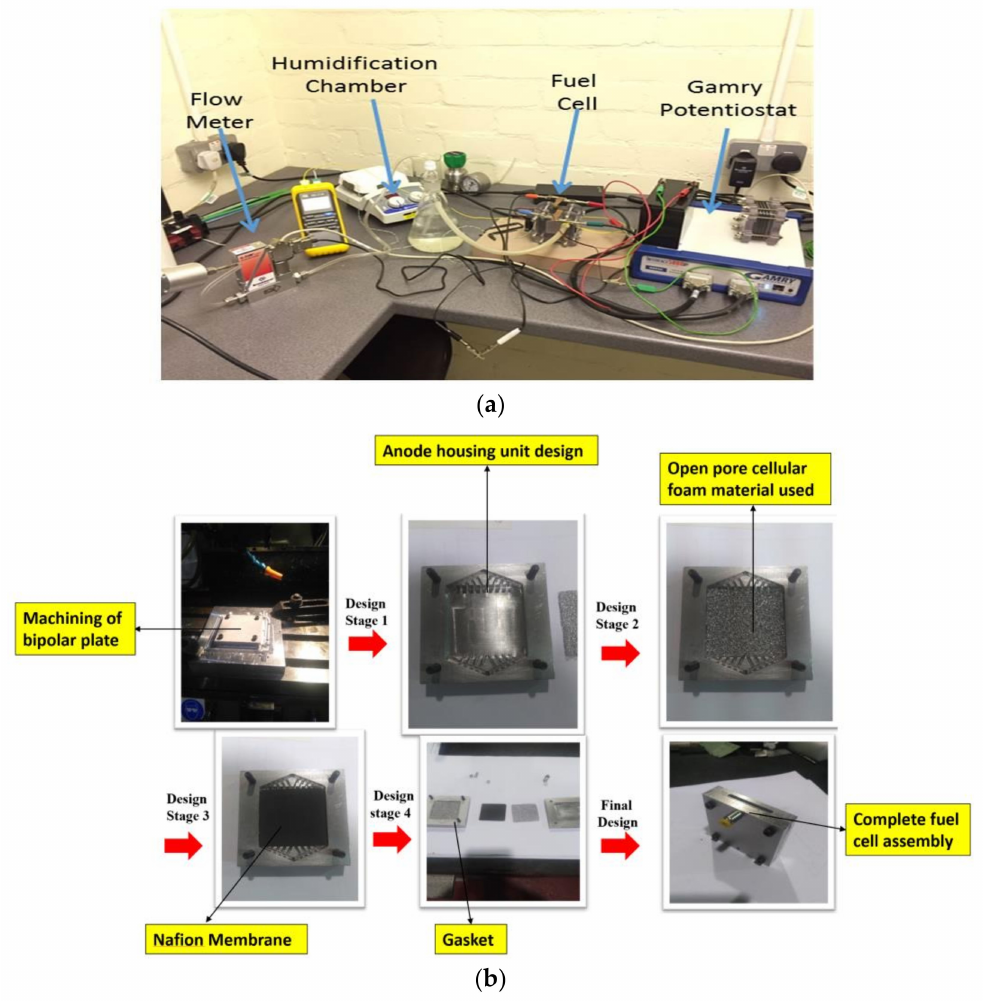
Figure 3. ( a ) Laboratory set-up ( b ) Development of the novel fuel cell using open pore cellular foam